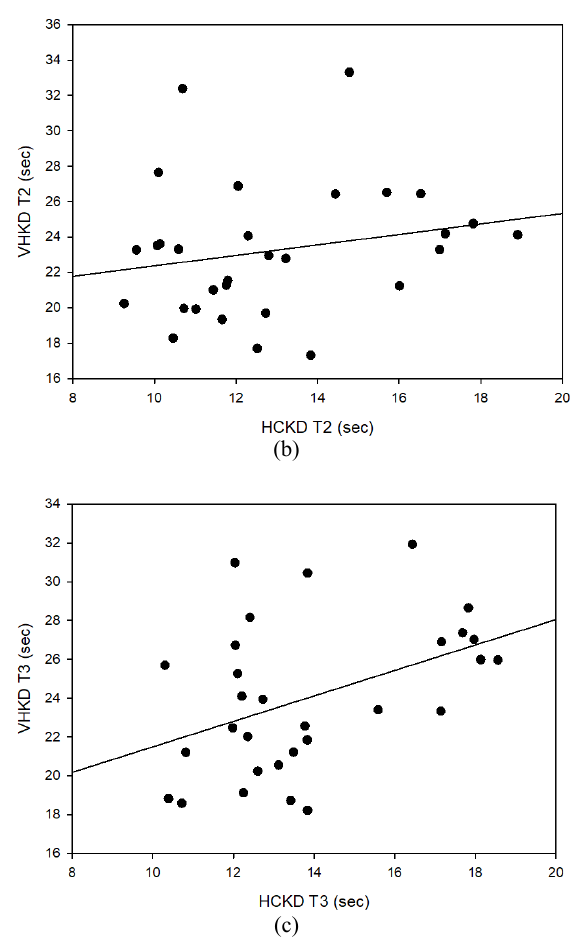
Figure 11. Correlation between HCKD and VHKD (a) Test 1, (b) Test 2, (c) Test 3